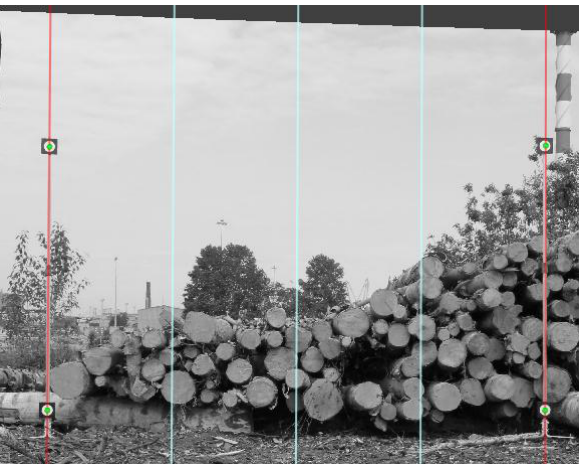
Figure 10. Log stack section orthophoto divided into sections for heights calculation Then the upper contour of log stack is detected and the points of its intersection with vertical section lines are determined. For these points corresponding points in the left image and in the right image by correlation technique. Then their 3D coordinates are calculated and they are projected into the orthphoto plane. The area of the segment is found as a sum of areas of 1-meter- trapezoidal sections (Figure